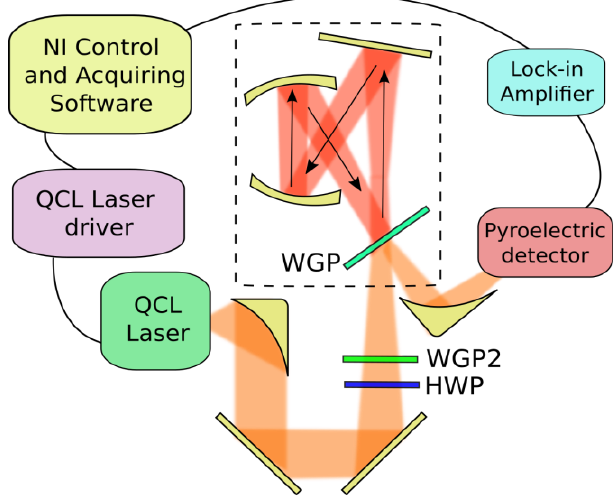
Figure 3. Experimental set-up. WGP and WGP2: Wire grid-polarizers, HWP: Half-wave plate.